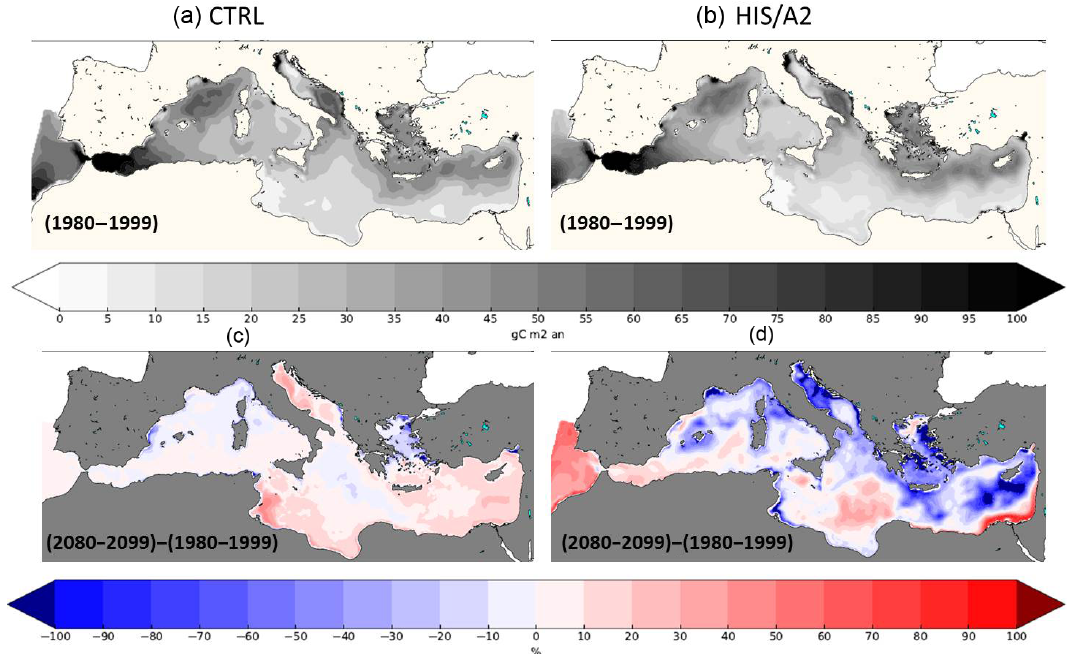
Figure 11. Present (1980–1999, a, b ) interannual average surface (0–200m) integrated primary production (gCm − 2 ) in the CTRL (a, c) and HIS/A2 (b, d) simulations. The bottom maps show the percentage of relative difference between the 2080–2099 and the 1980–1999 periods in the CTRL (a, c) and HIS/A2 (b, d) simulations.